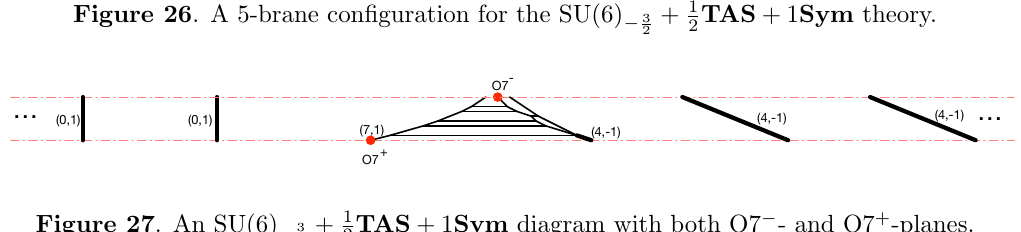
Figure 26 . A 5-brane con(cid:12)guration for the SU(6)